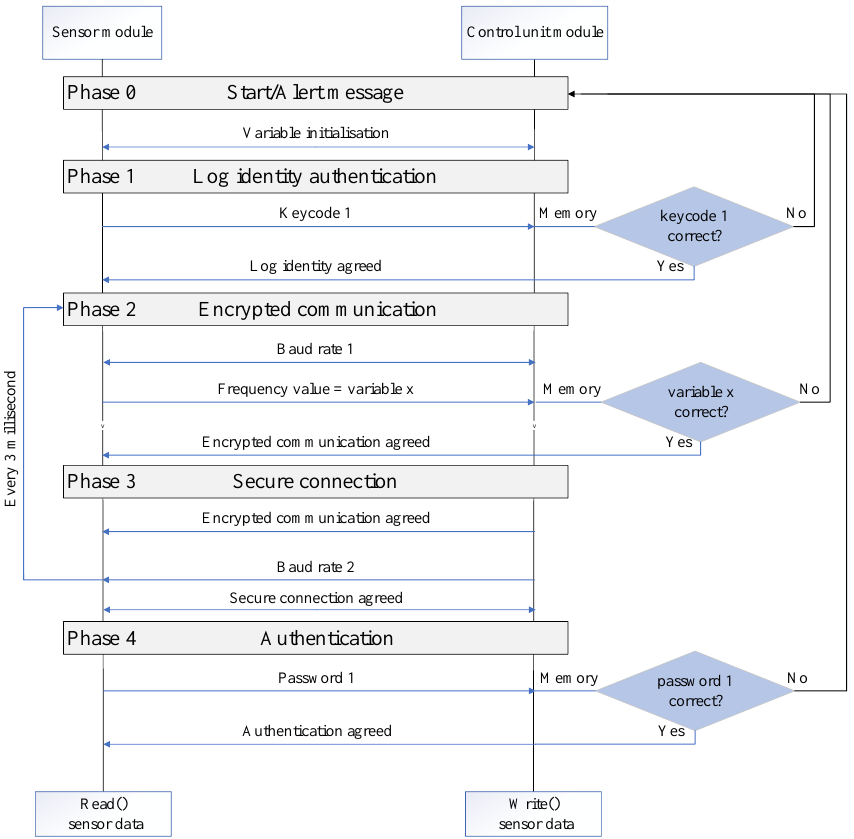
Figure 11. Log identity authentication, encrypted communication, secure connection, and authentication (LCCA) protocol.